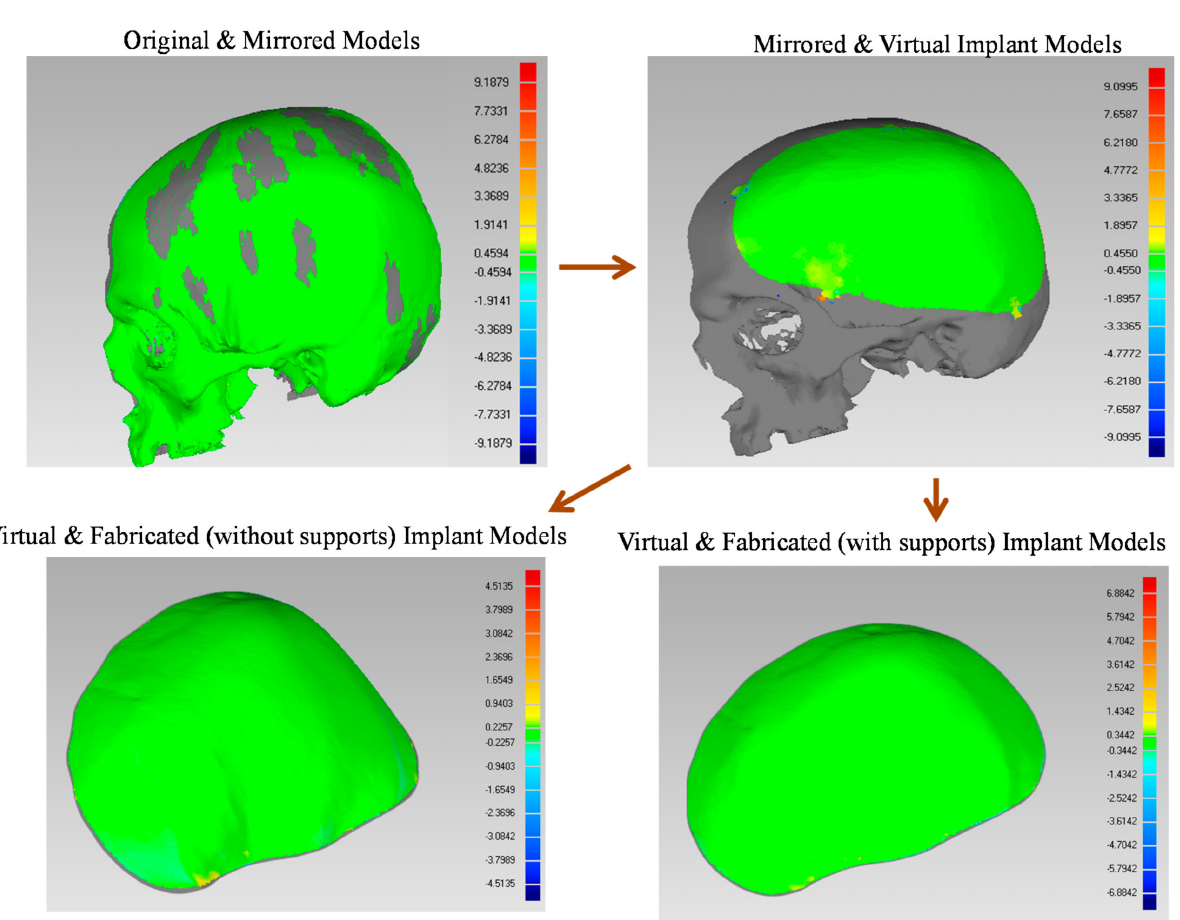
Figure 15. Graphical display of 3D deviation